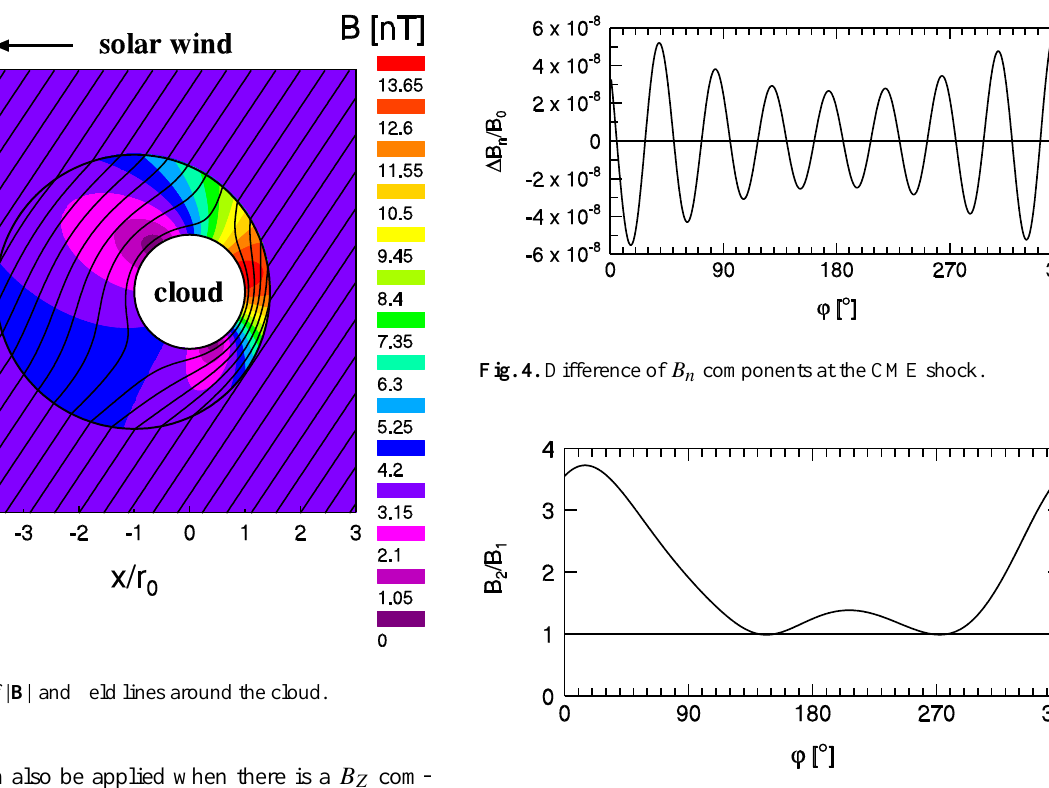
Fig. 5. Magnetic field magnitude jump at the CME